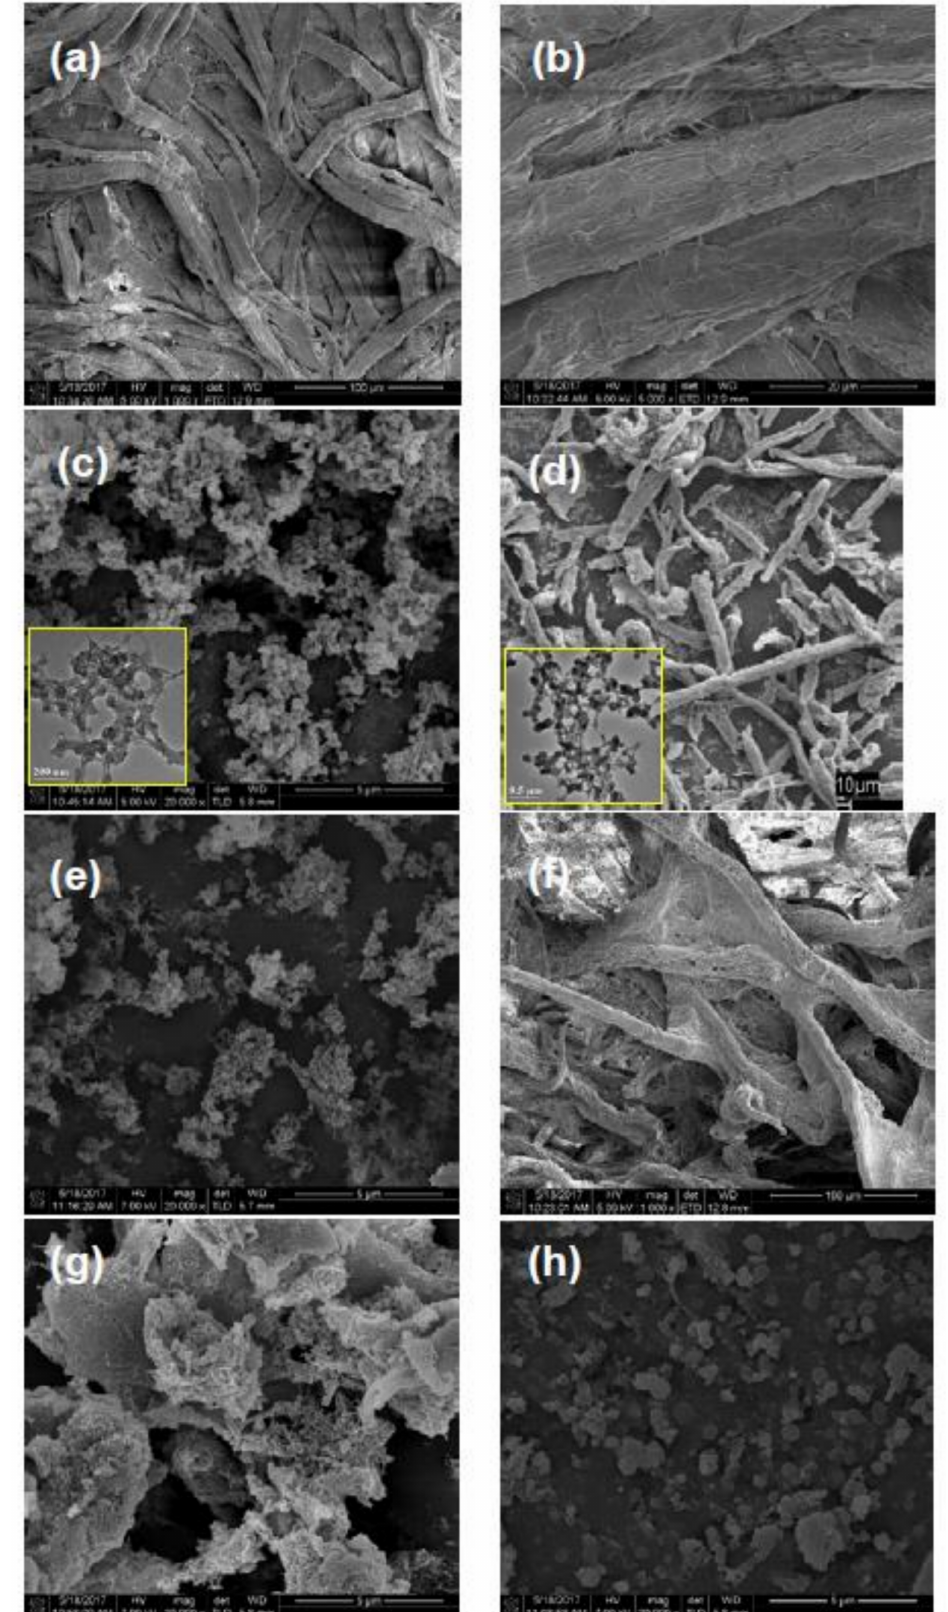
Figure 2. Scanning electron microscope (SEM) or field-emission scanning electron microscope (FE-SEM) images of initial bleached eucalyptus kraft pulp (BEP) and esterified BEP fibers. ( a ) and ( b ) BEP; ( c ) S10T80t1; ( d ) N10T80t1; ( e ) S07T85t1; ( f ) N10T60t2; ( g ) S05T80t2; ( h )